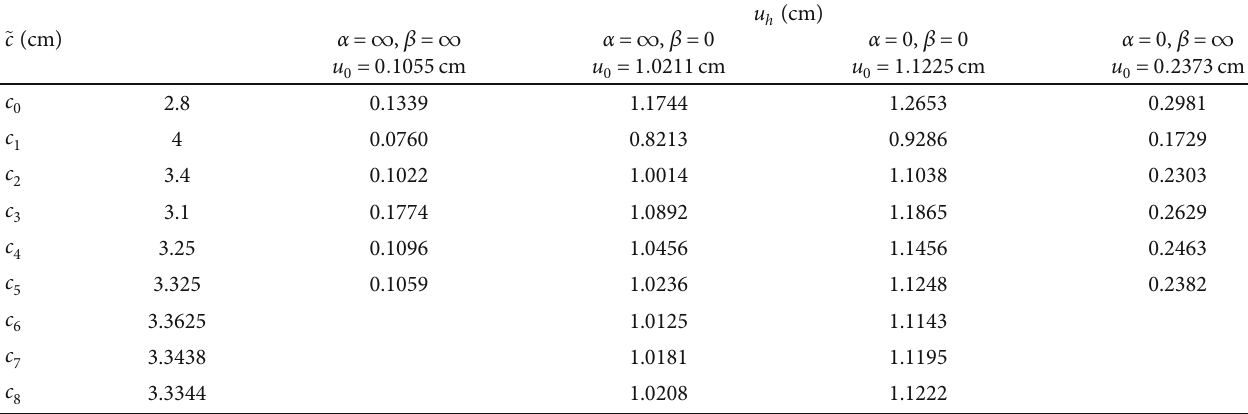
and β , after determining the solution interval, with a preci- sion of ε = 10 − 3 , the size value of ~ c is obtained in 4 steps with 0 : 25 % error for cases α = ∞ and β = ∞ and α = 0 and β = ∞ , while the size value of ~ c is obtained in 7 steps with 0 : 033 % error for cases α = ∞ and β = 0 and α = 0 and β = 0 .